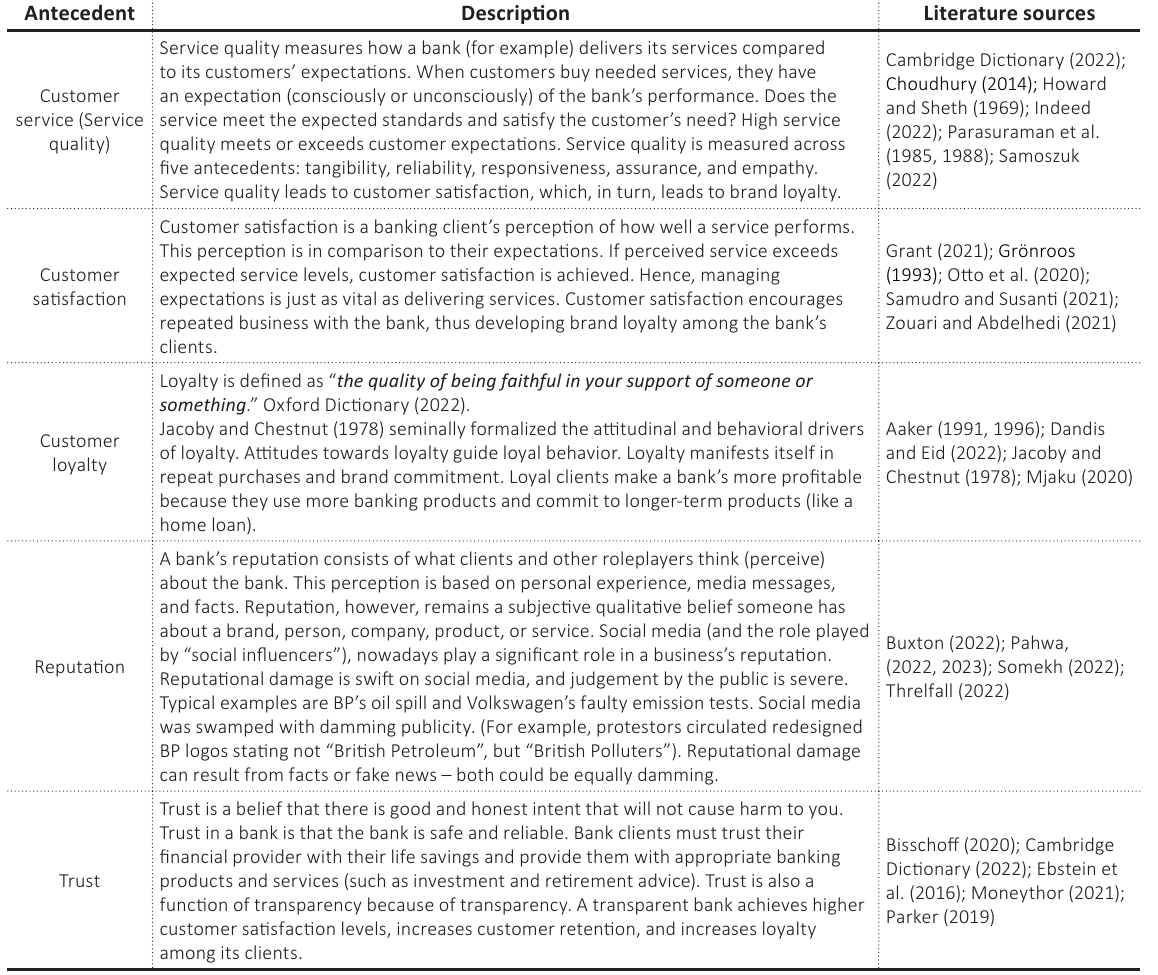
Table 1. Description and supporting sources of Khokhar’s brand loyalty